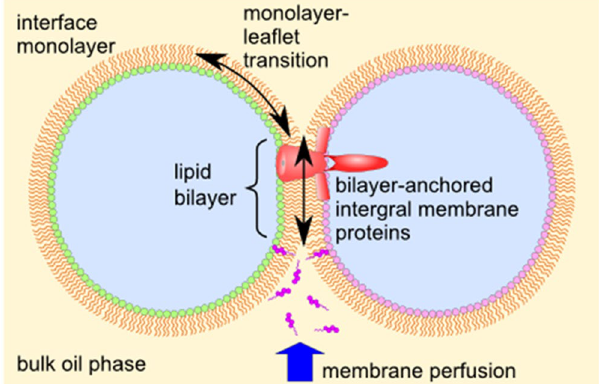
Figure 4. A schematic representation of the water-in-oil droplet system, including the CBB. The lipids in the interface monolayer and those in a leaflet of the bilayer are freely diffusible (monolayer-leaflet transition). Integral membrane proteins, such as channels, freely diffuse but within the bilayer (bilayer-anchored). Hydrophobic substances perfuse around the membrane embedded channels via partitioning to either monolayer or